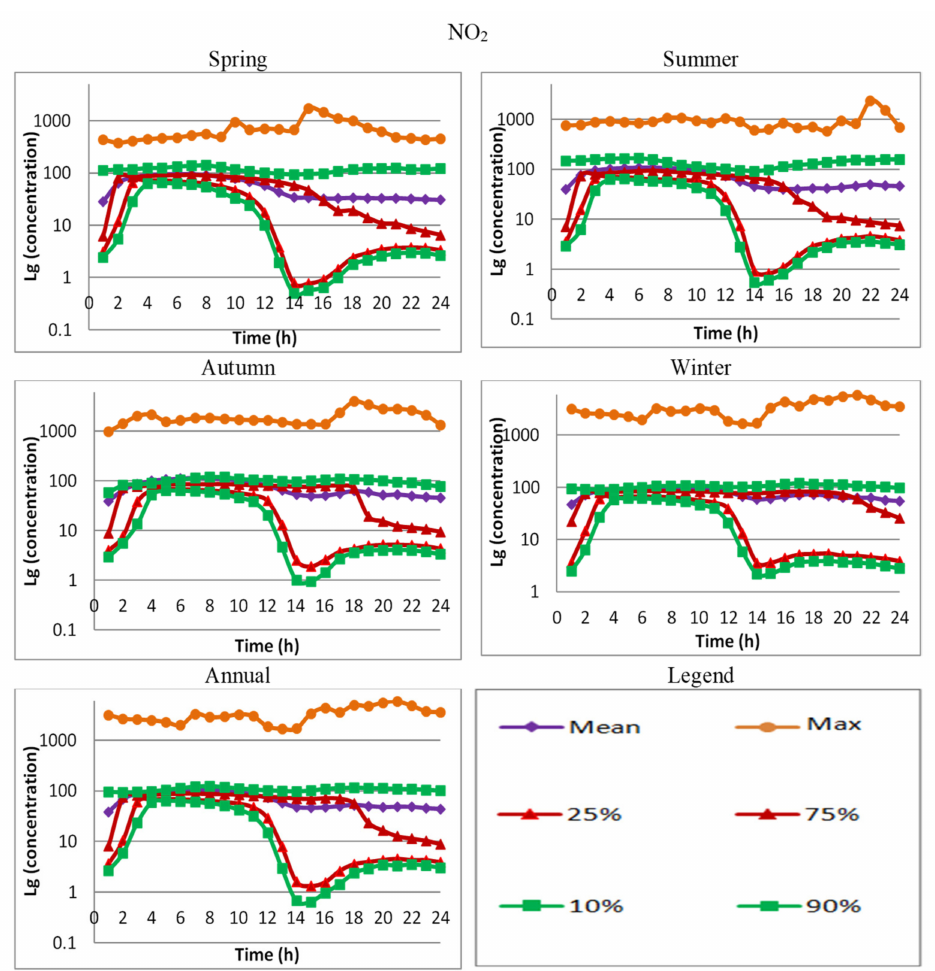
Figure 8. Spatial and diurnal variations of the annual and seasonal ensembles of surface NO 2 ( µ g/m 3 ) concentrations behavior in logarithmic scale for Orlov most for the period 2008–2014.